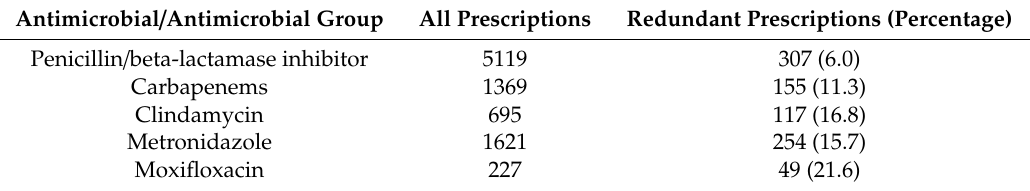
Table 2. Redundant anaerobic prescriptions. Data from 218 hospitals that participated in the point prevalence survey 2016.